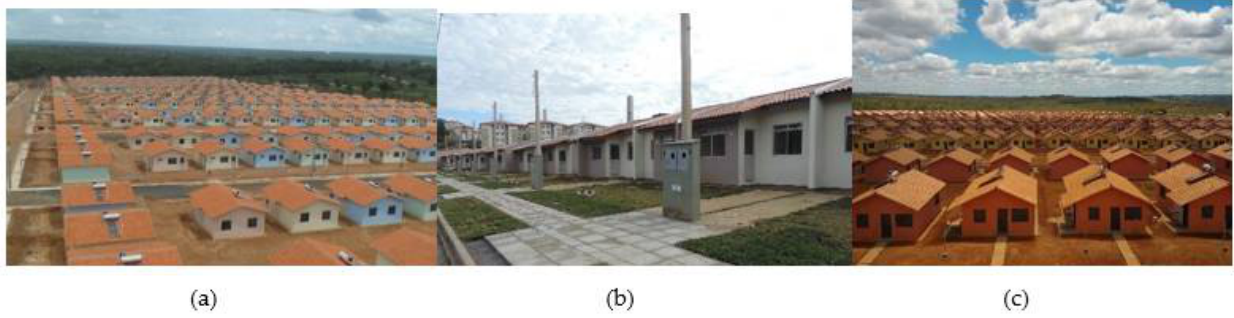
Figure 1. Examples of newly built developments of house units: ( a ) Residencial Veneza in the state of Maranhão—development of detached units built in 2014; ( b ) Residencial Pinheiros in the state of Paraná—development of row-houses built in 2015; ( c ) Residencial Dona Sílvia in the state of Minas Gerais—development of detached units built in 2014. Photos by Ministério do Planejamento [25].